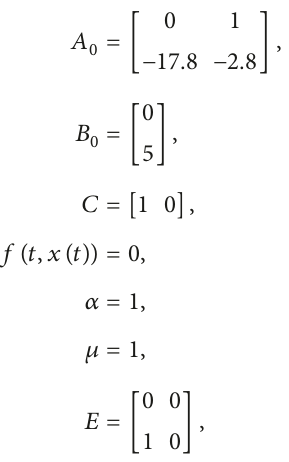
robot 𝜏 𝑑 (𝑡) = 1000 sin (0.5𝜋𝑡) 𝑁 . Let 𝑥 𝑑 (𝑡) = [𝑞 𝑑 and 𝑥 𝑘,𝑗 (𝑡) = [𝑞 𝑘,𝑗